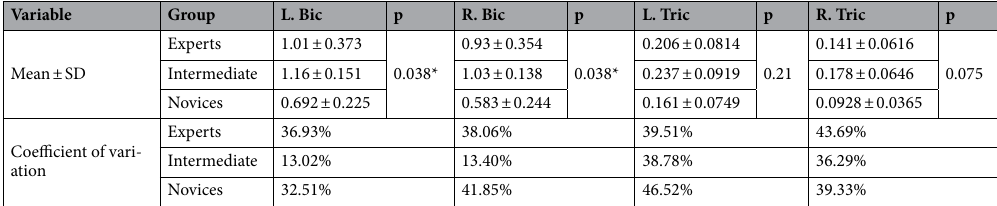
Table 2. Duration of muscle activation time during the free-throw made [s] (mean ± standard deviations). * Statistical significance >0.05.